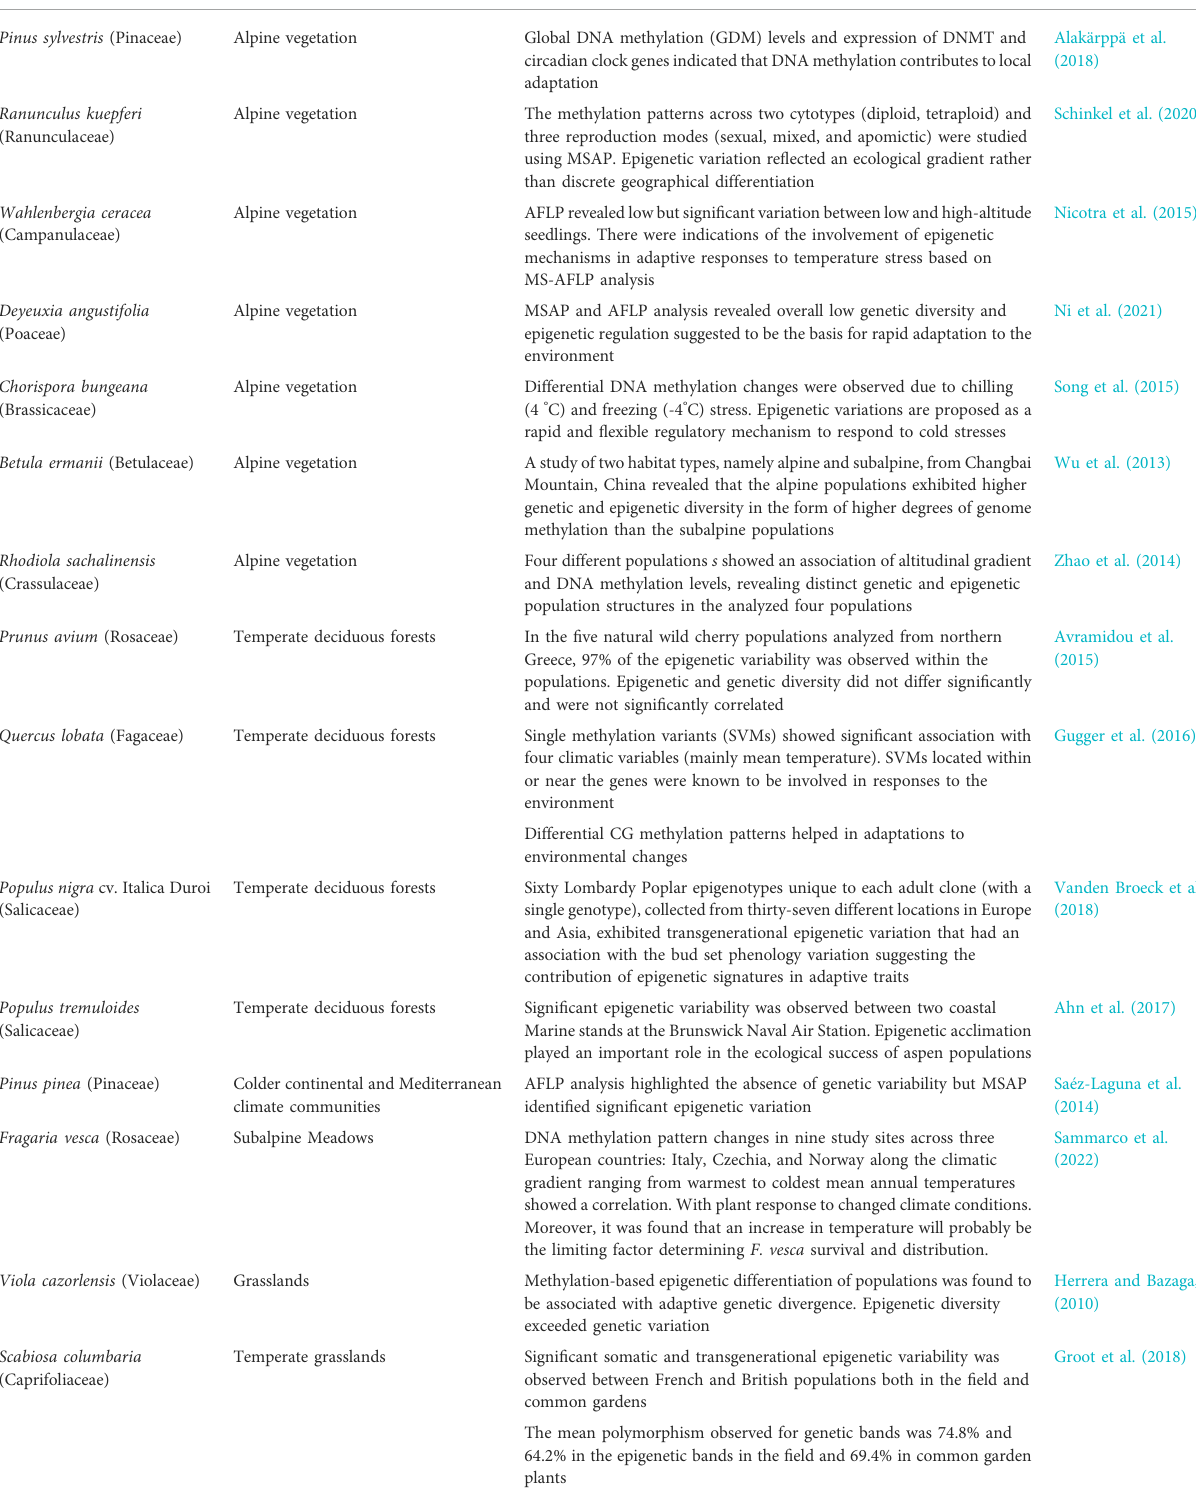
TABLE 1 Instances of epigenetic regulation in plant species from different ecological